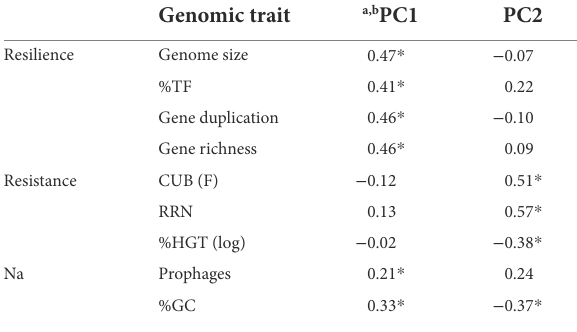
TABLE 1 Loadings of genomic traits on principal components (all genomes, Figure